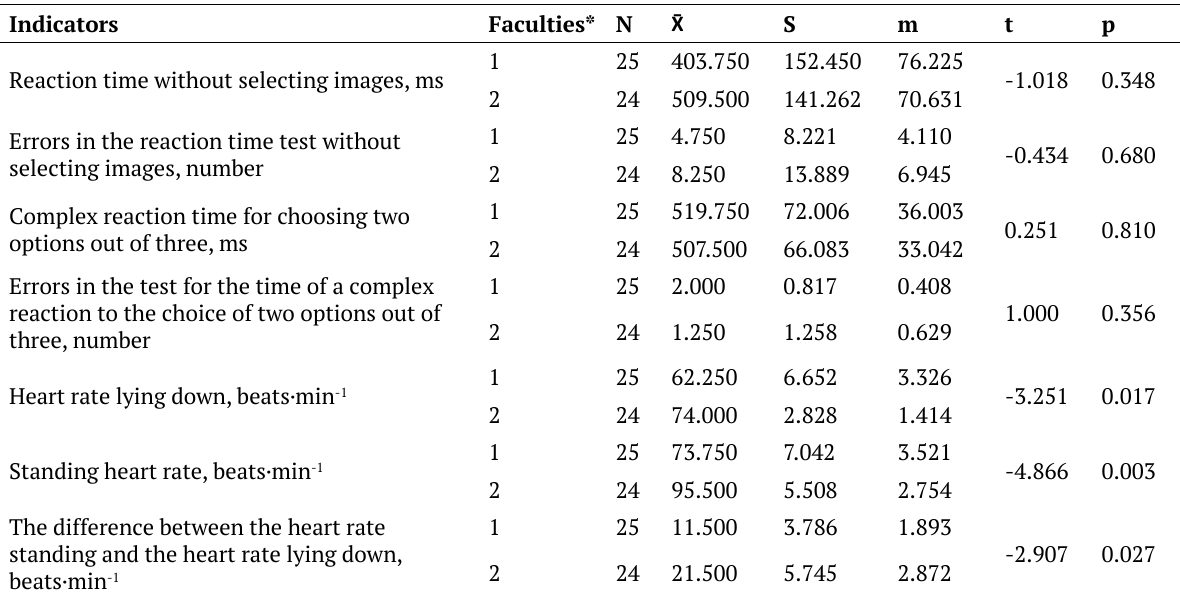
Table 2. Indicators of properties of the nervous system and functional capabilities of the cardiovascular system of students of the faculties of arts and physical education and sports Indicators